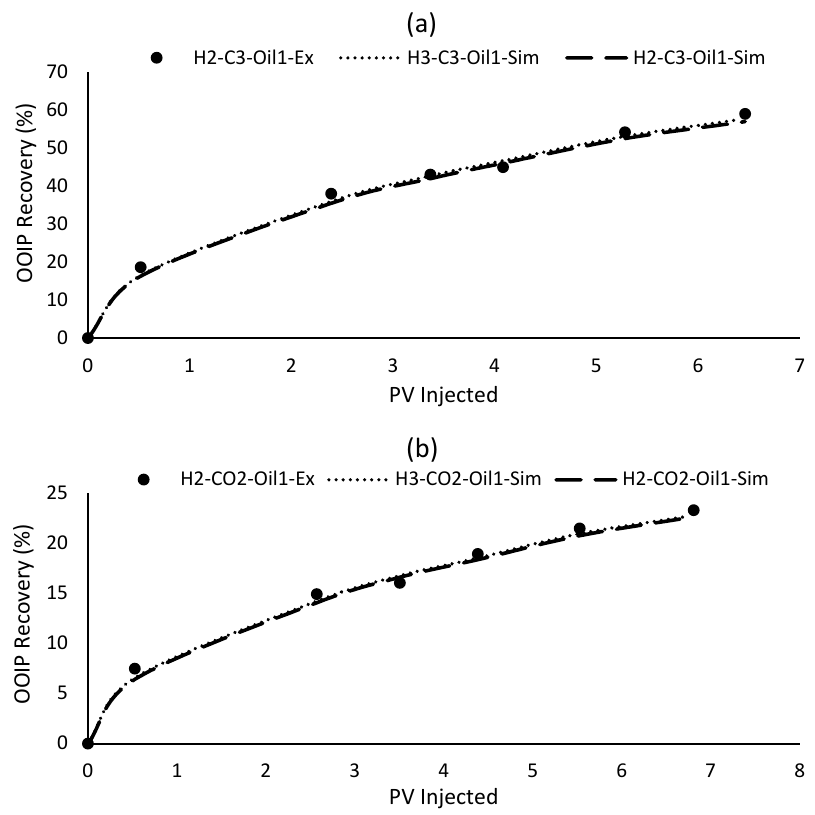
Figure 16. The effect of fracture intensity on the recovery factors in conventional VAPEX and patterns H2 and H3 using propane ( a ) and carbon dioxide ( b ).